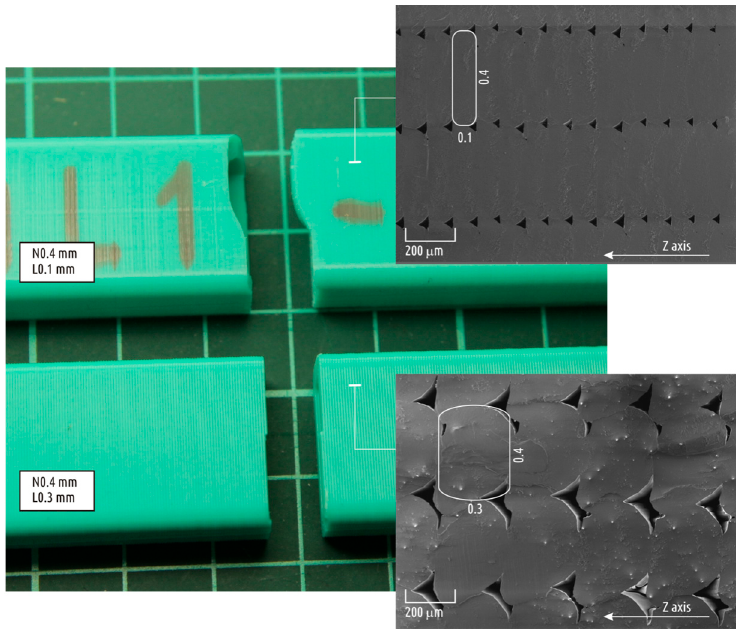
Figure 3. Appearance ( left ) of typical samples with relatively small ( top ) and relatively large ( bottom ) layer thickness, and SEM images of their cross-sections ( right ).